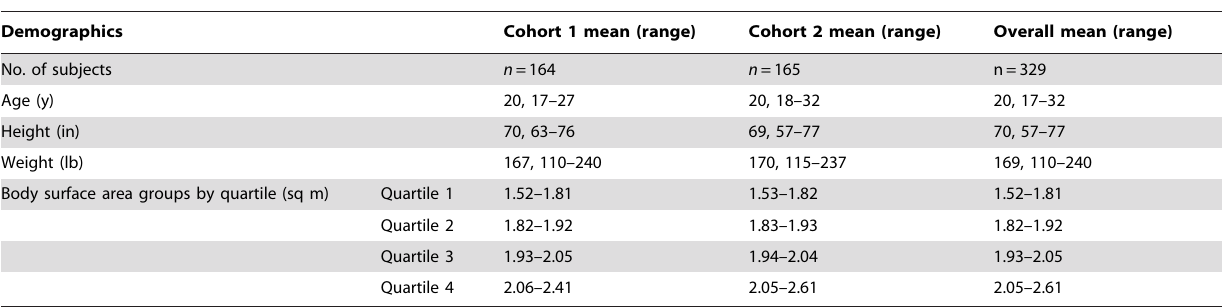
Table 2. Demographics of study subjects.